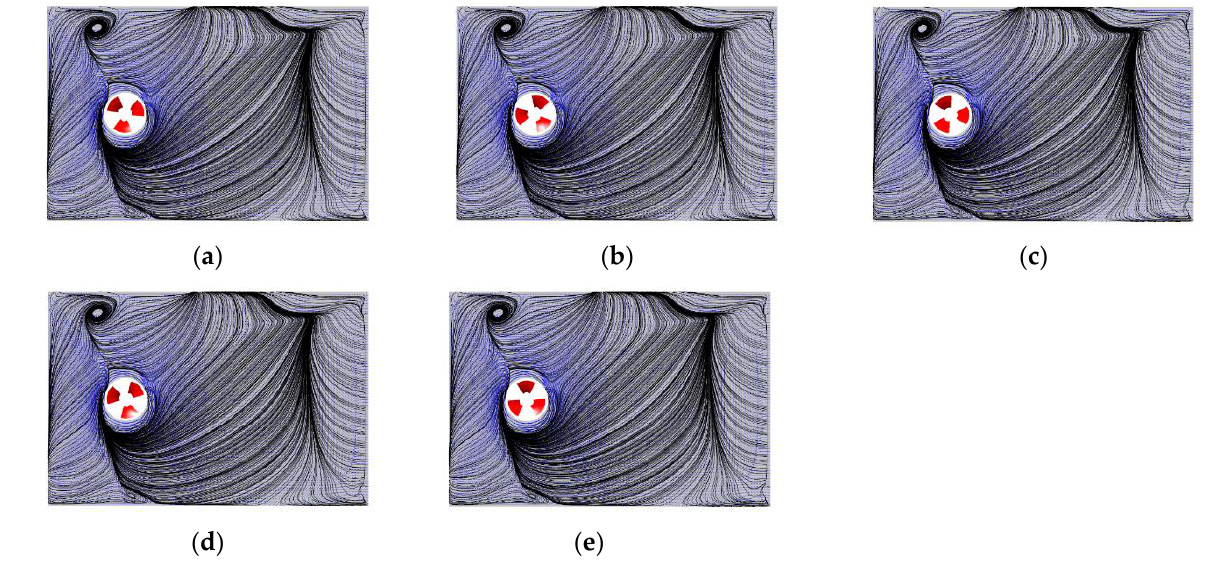
Figure 13. Streamline near the roof at different time points. ( a ) 1/5T, ( b ) 2/5T, ( c ) 3/5T, ( d ) 4/5T, ( e ) T.